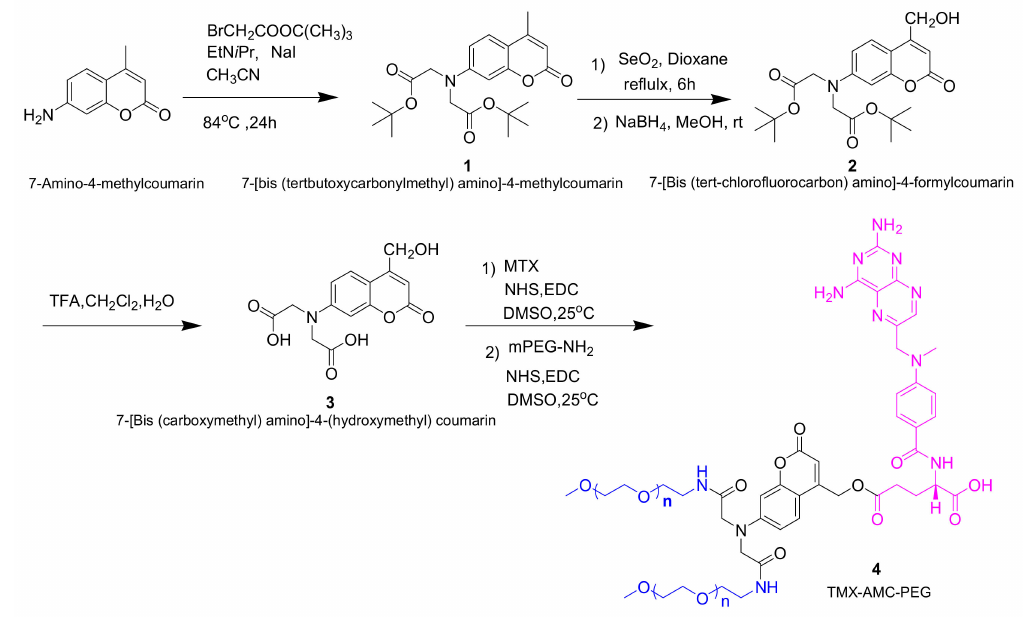
Scheme 1. The synthesis of MTX-AMC-PEG